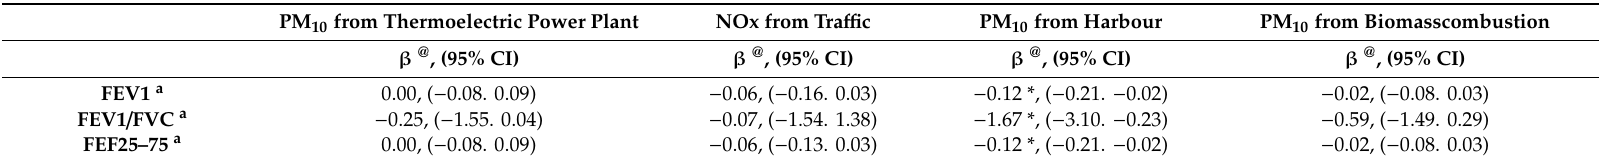
Table 4. Association between PM10 from thermoelectric power plant, form harbour, from biomass combustion, and NOx from tra ffi c and lung function. Regression coe ffi cient ( β and 95%